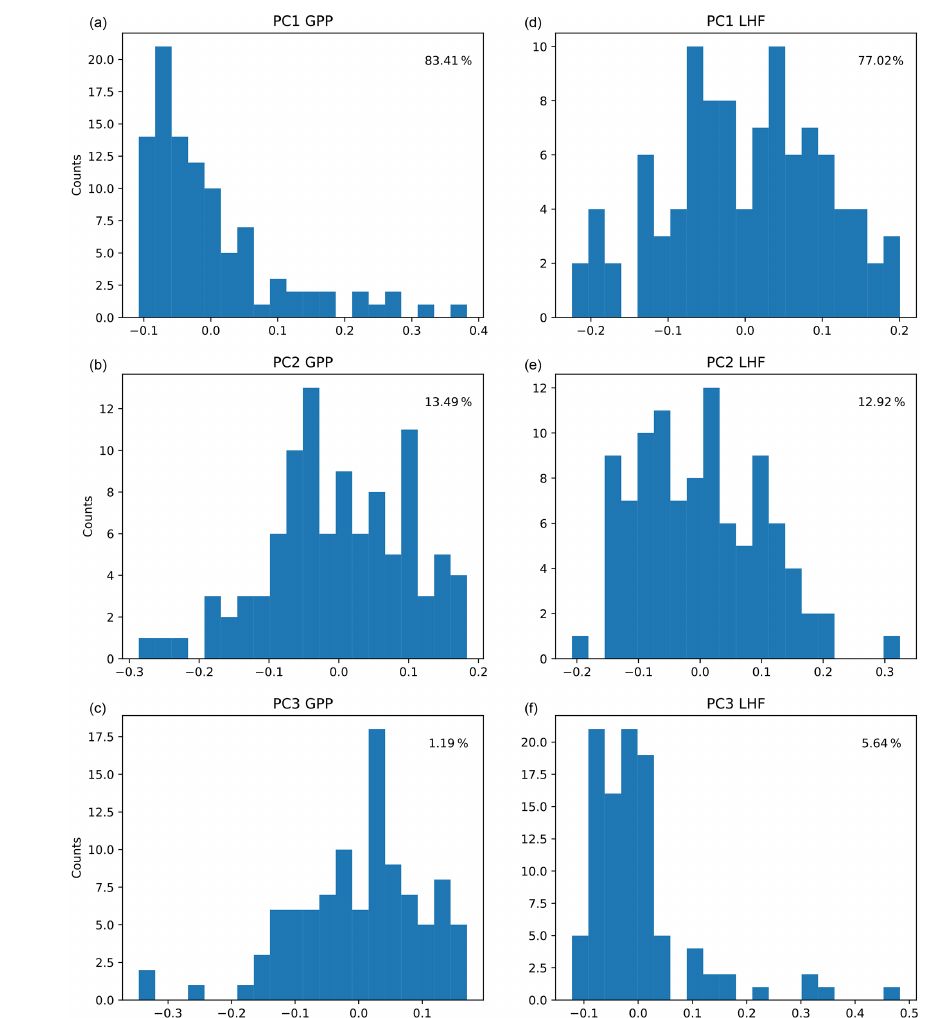
Figure 3. Distributions of the first three principal components (PCs) across CLM PPE ensemble members for GPP (a, b, c) and LHF (d, e, f) . The percent variance explained by each mode is shown in each panel in the upper right